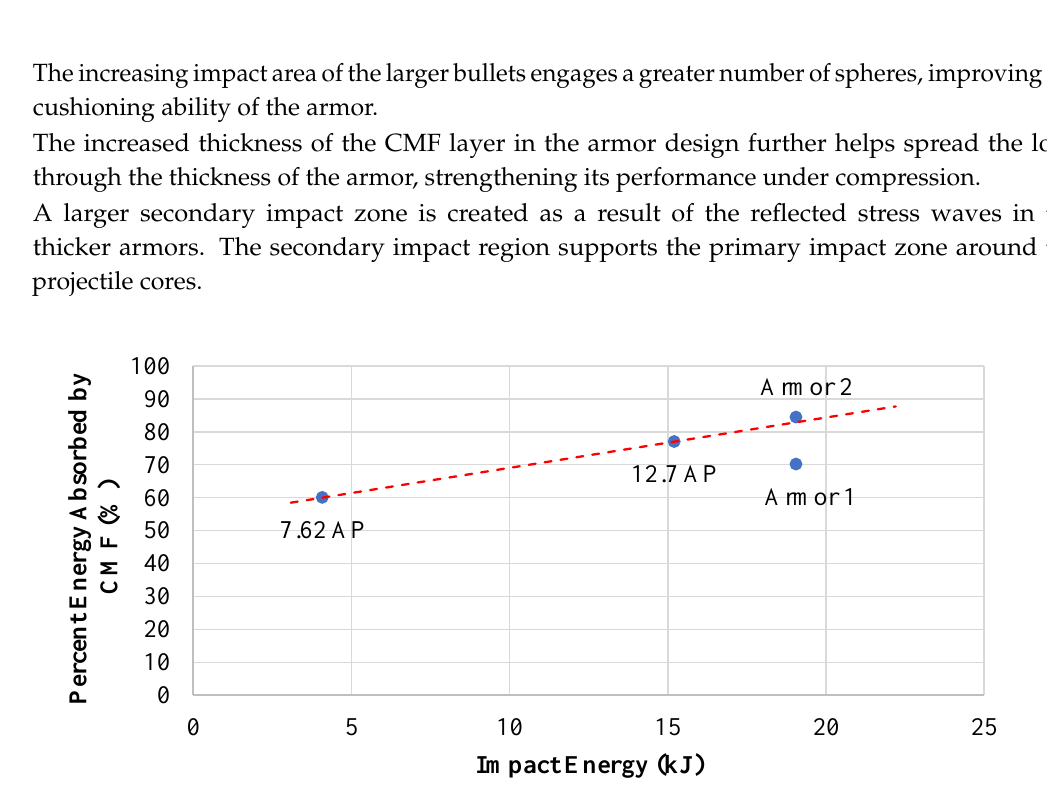
Figure 9. Percentage of energy absorbed by the CMF layer as a function of the impact energy imparted by each ballistic threat. The linear fit between the 7.62 [16] and 12.7 mm [17] AP data shows how the 14.5 × 114 mm B32 API data currently compare with its higher impact energy.